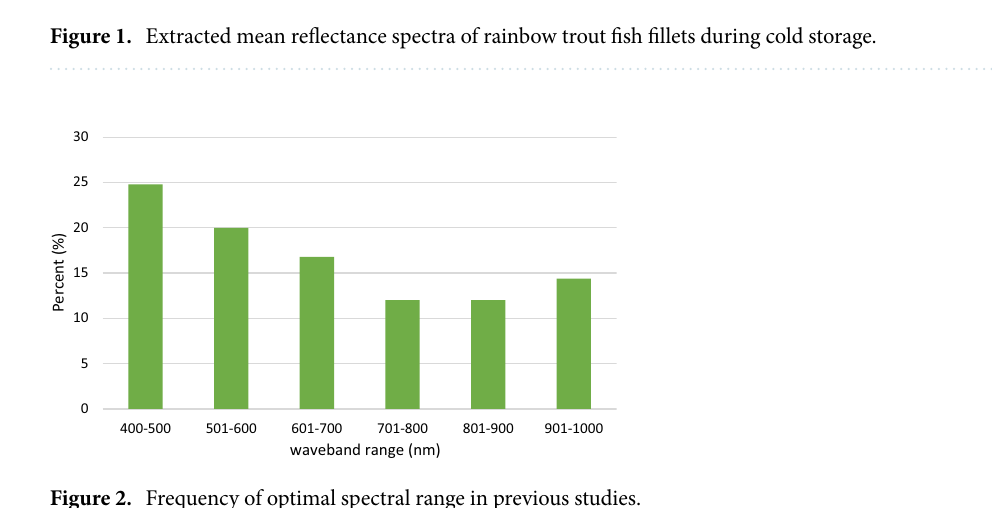
Figure 2. Frequency of optimal spectral range in previous